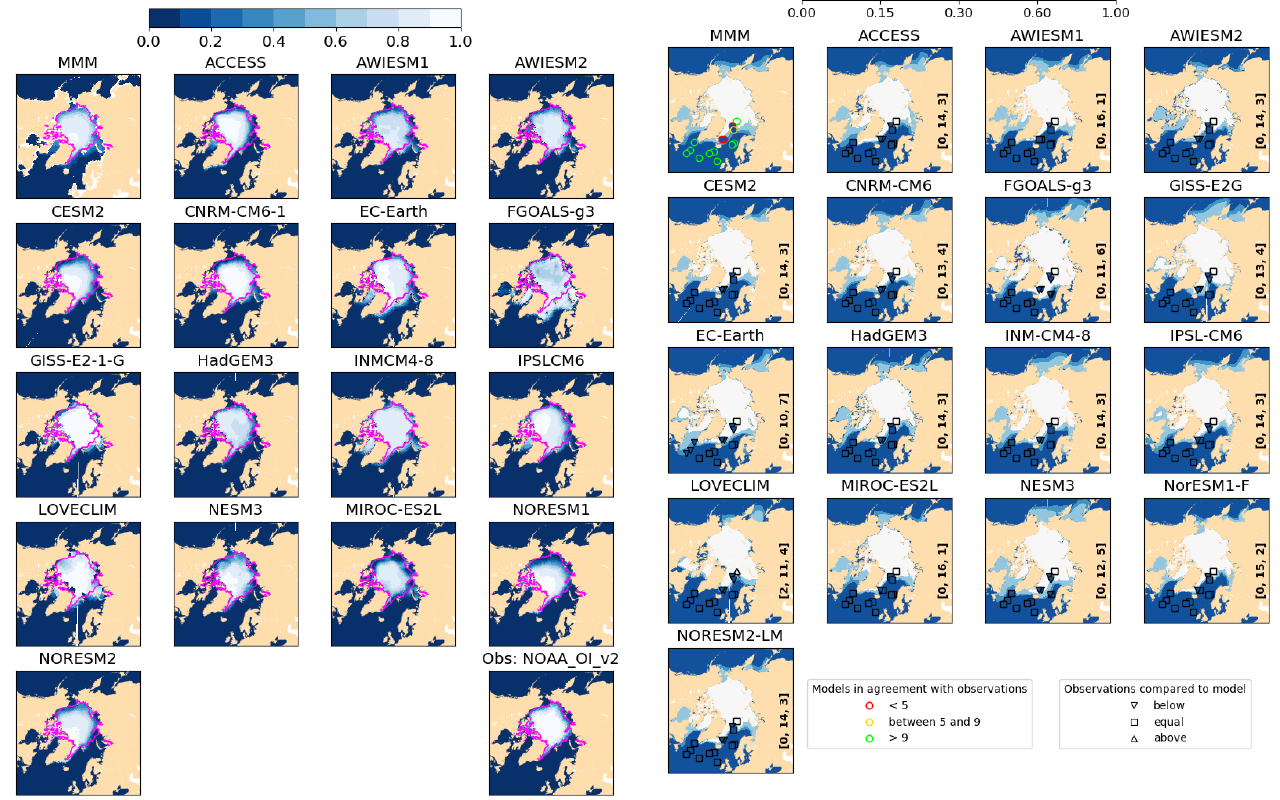
Figure 3. PI sea ice concentration for the month of minimum SIA as computed for Fig. 2. The magenta contour shows the 0.15 isocon- tour of the NOAA_OI_v2 observations (Reynolds et al., 2002, see the Data availability section) averaged over the years 1982–2001.